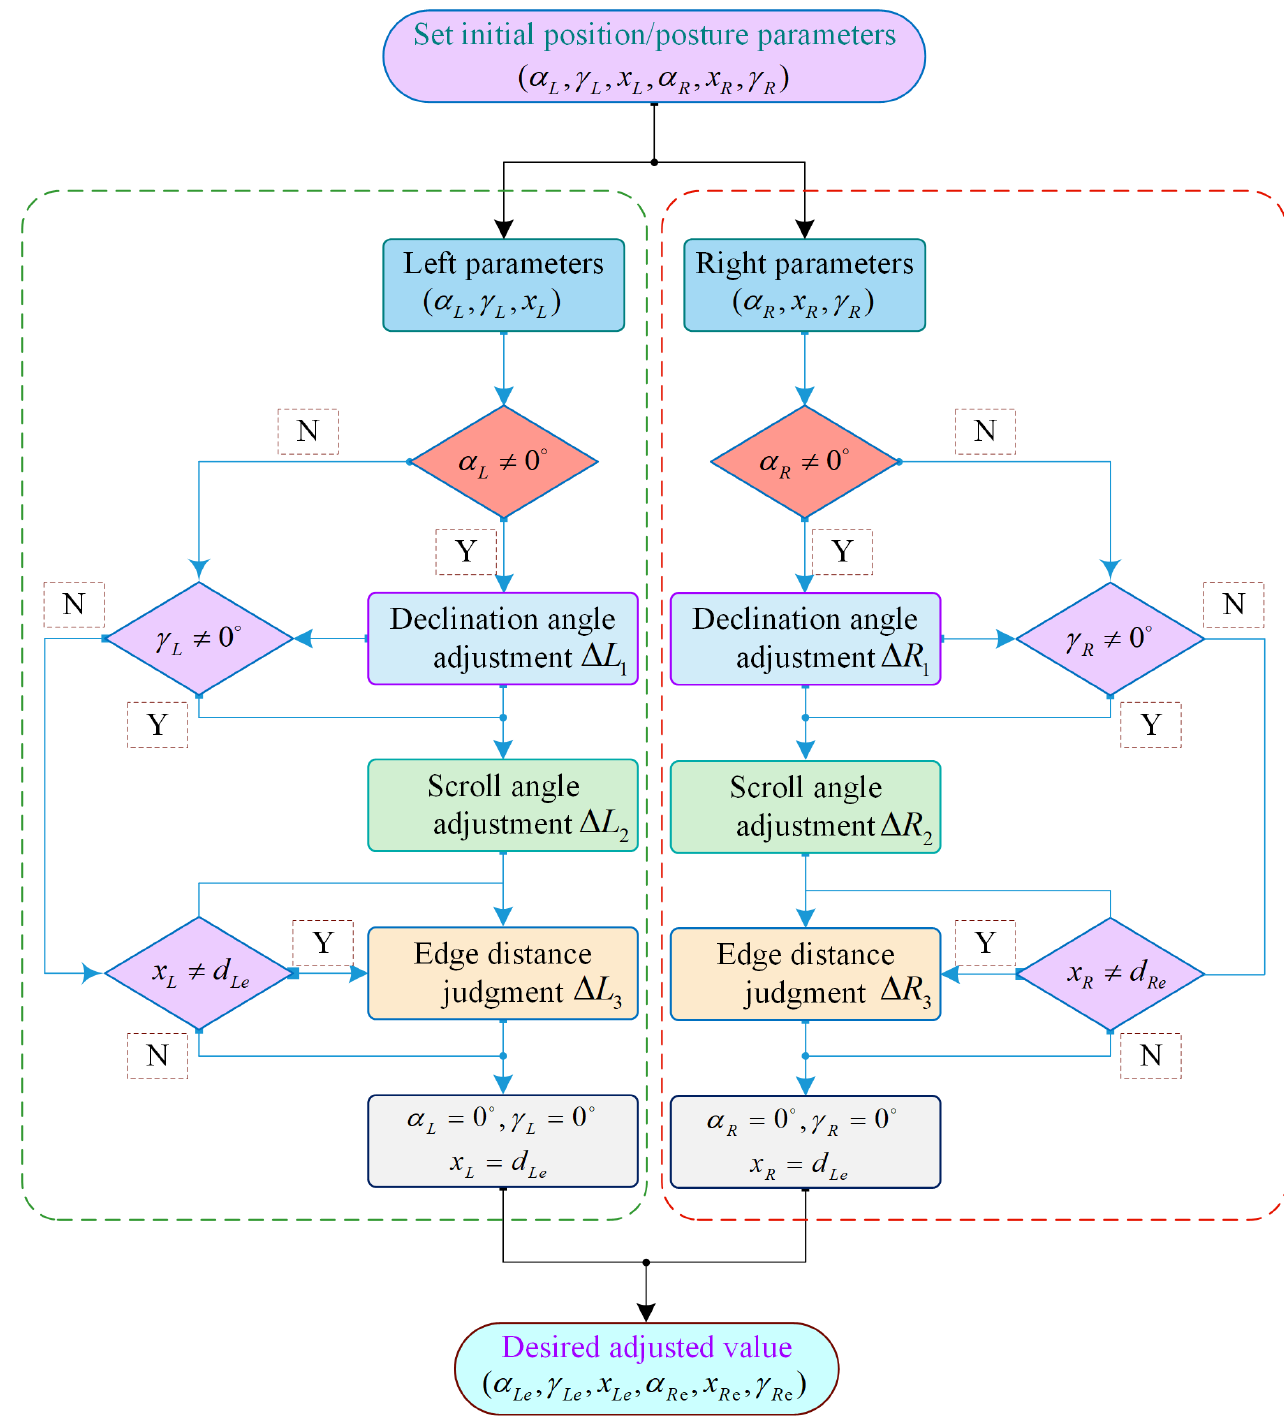
Figure 10. Desired position/posture coordination adjustment process of the ESR.